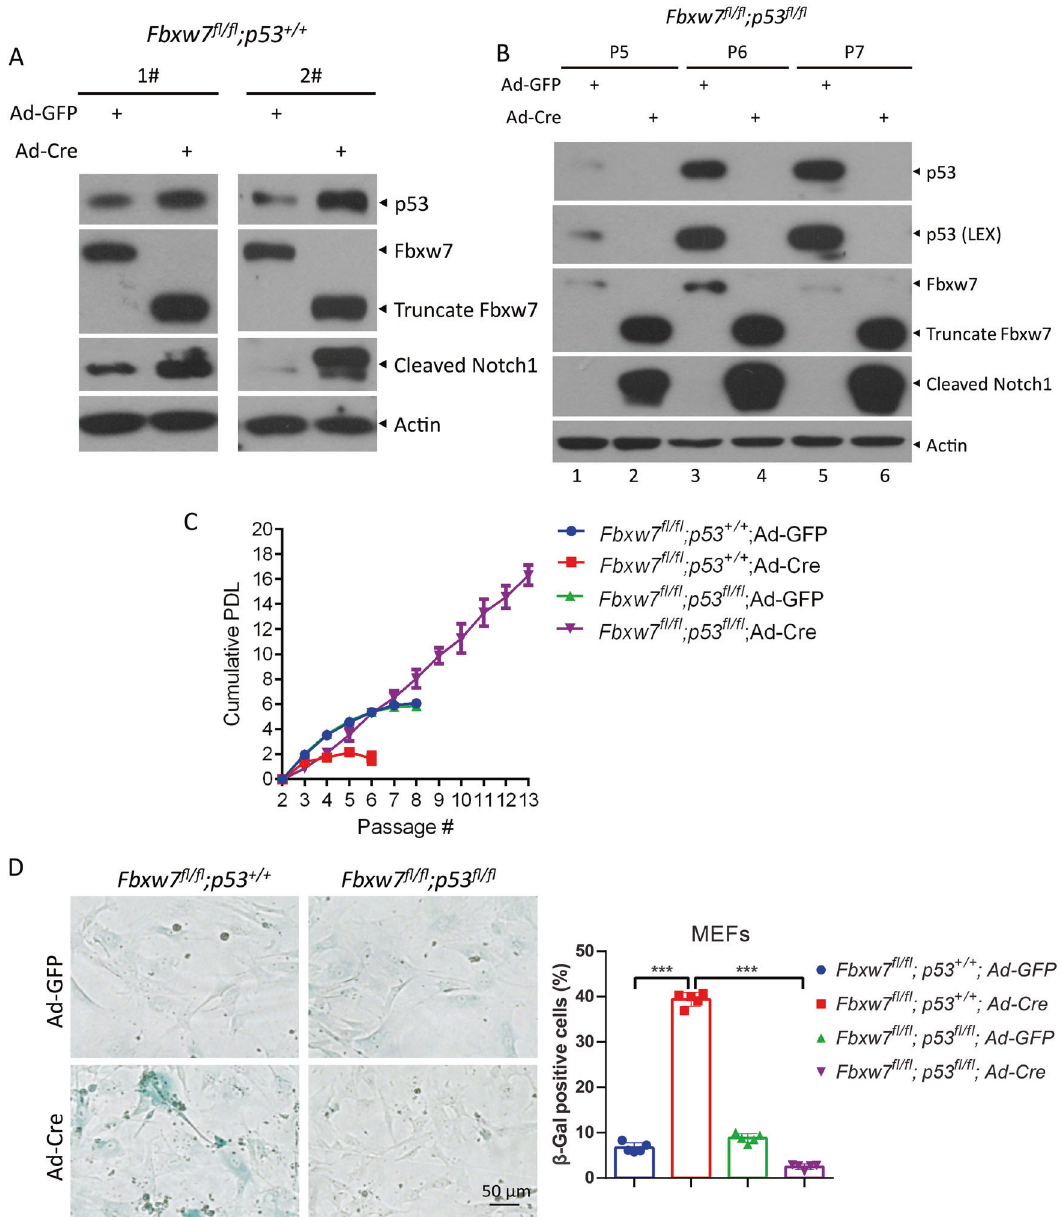
Fig. 3 Fbxw7 deletion accelerates the senescence of primary mouse embryonic fi broblasts (MEFs) by inducing p53 expression. A Two independent primary Fbxw7 fl / fl ;p53 + / + MEFs were infected with the adenovirus-expressing Cre recombinase (Ad-Cre) or adenovirus-expressing green fl uorescent protein (Ad-GFP) for 72 h, and then subjected to IB with the indicated antibodies. B Primary Fbxw7 fl / fl ;p53 fl / fl MEFs were infected with Ad-Cre or Ad-GFP, then passaged for indicated times, followed by IB with the indicated antibodies. C , D Primary Fbxw7 fl / fl ;p53 + / + and Fbxw7 fl / fl ;p53 fl / fl MEFs were infected with Ad-Cre or Ad-GFP, followed by cell passage on a 3T9 protocol to measure the cumulative population doubling level ( C ), or SA- β -Gal staining at P6 ( D left). The percentage of SA- β -Gal-positive cells in the total number of cells was determined ( D right). Scale bar represents 50 μ m. Data are presented as the mean ± SD. *** p <